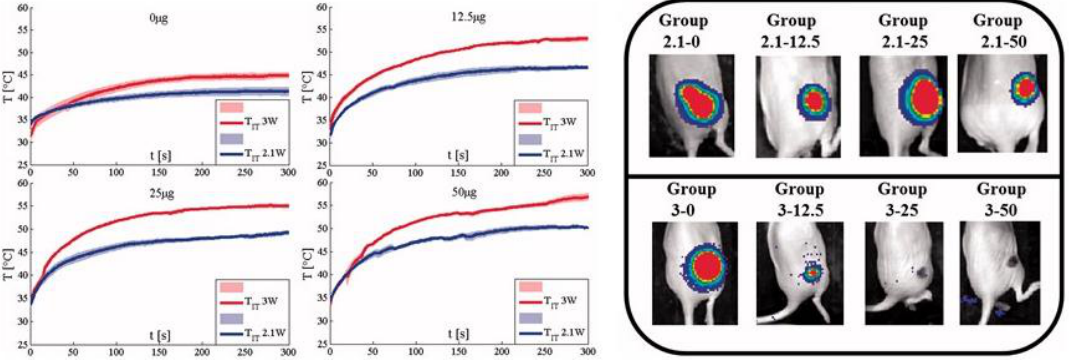
Figure 10. AuNRs-mediated LA in mice bearing MDA-MB-231 human breast cancer. Temperature evolutions measured inside the tumor during ablation performed at 2.1 W and 3 W. Xenogen images acquired two days after ablation [Reproduced from [96], with permission from Taylor & Francis, Copyright 2019].